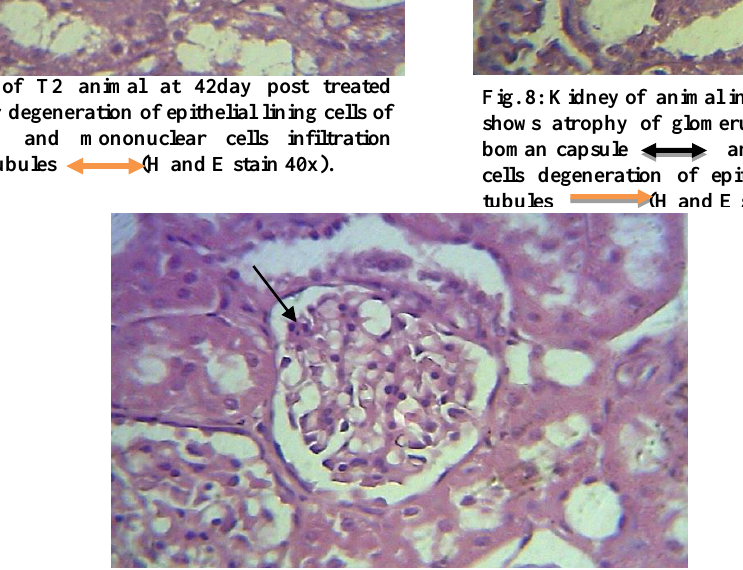
Fig. 9: Kidney of animal in T3 group 42 day post treated shows no clear lesions except congested blood vessels (H and E stain